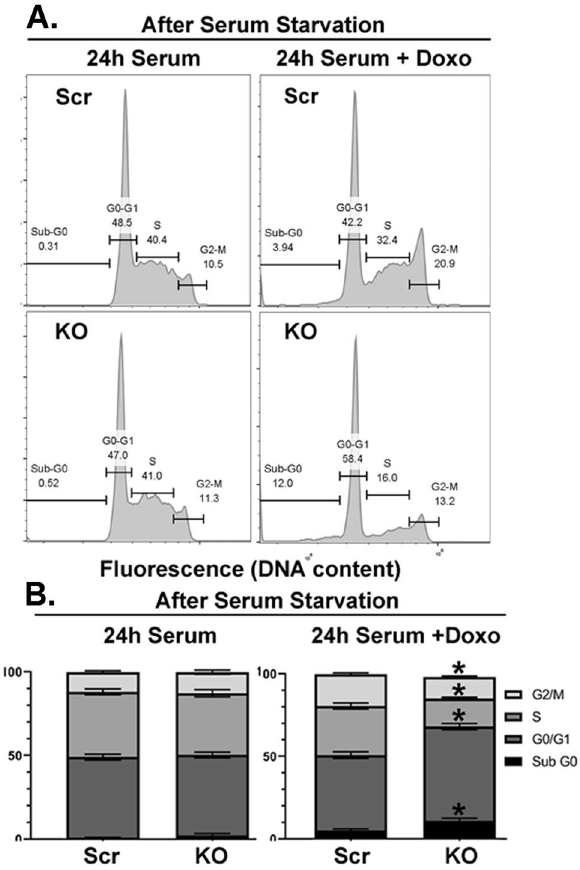
Figure 4. TRPM2 KO alters cell cycle distribution after exposure to doxorubicin. TRPM2 KO or Scr control SH-SY5Y cells were synchronized in culture by 12–18 h of serum deprivation, followed by refeeding for 24 h with 10% FBS with or without 0.3 µM doxorubicin. Percent of cells in different phases of the cell cycle was determined as described in “Methods”. ( A ) Tracing of the number of cells in different phases of the cell cycle in one of six experiments. ( B ) Mean ± S.E.M. percent of cells in each phase of the cell cycle (Sub-G0, G0/G1, S, or G2/M) in six experiments (n = 12/group). Statistics: unpaired, two-tailed t-test, *p < 0.006, Scr vs